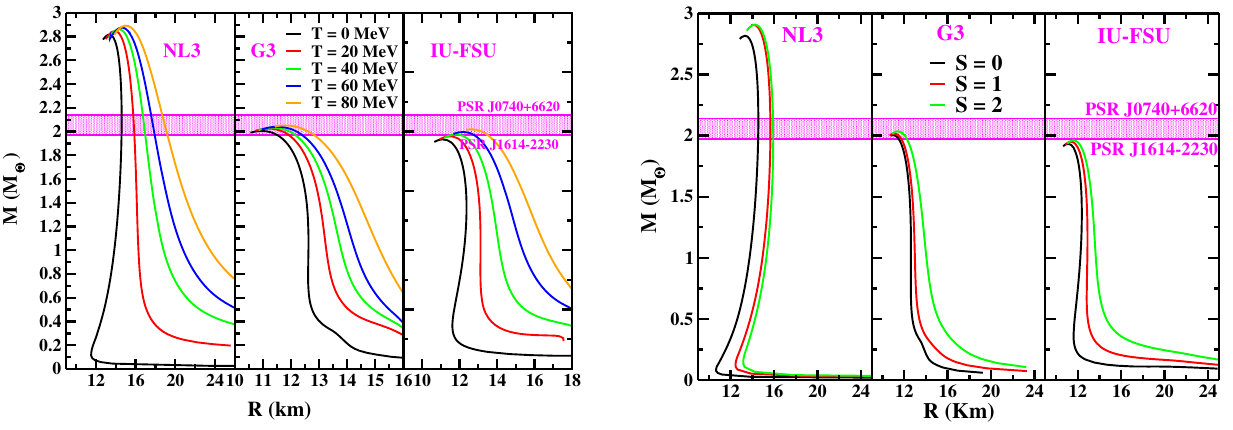
Fig. 11 M-R profile of proto-neutron star at different entropy for NL3 (left panel), G3 (middle) and IU-FSU (right panel) parameter sets